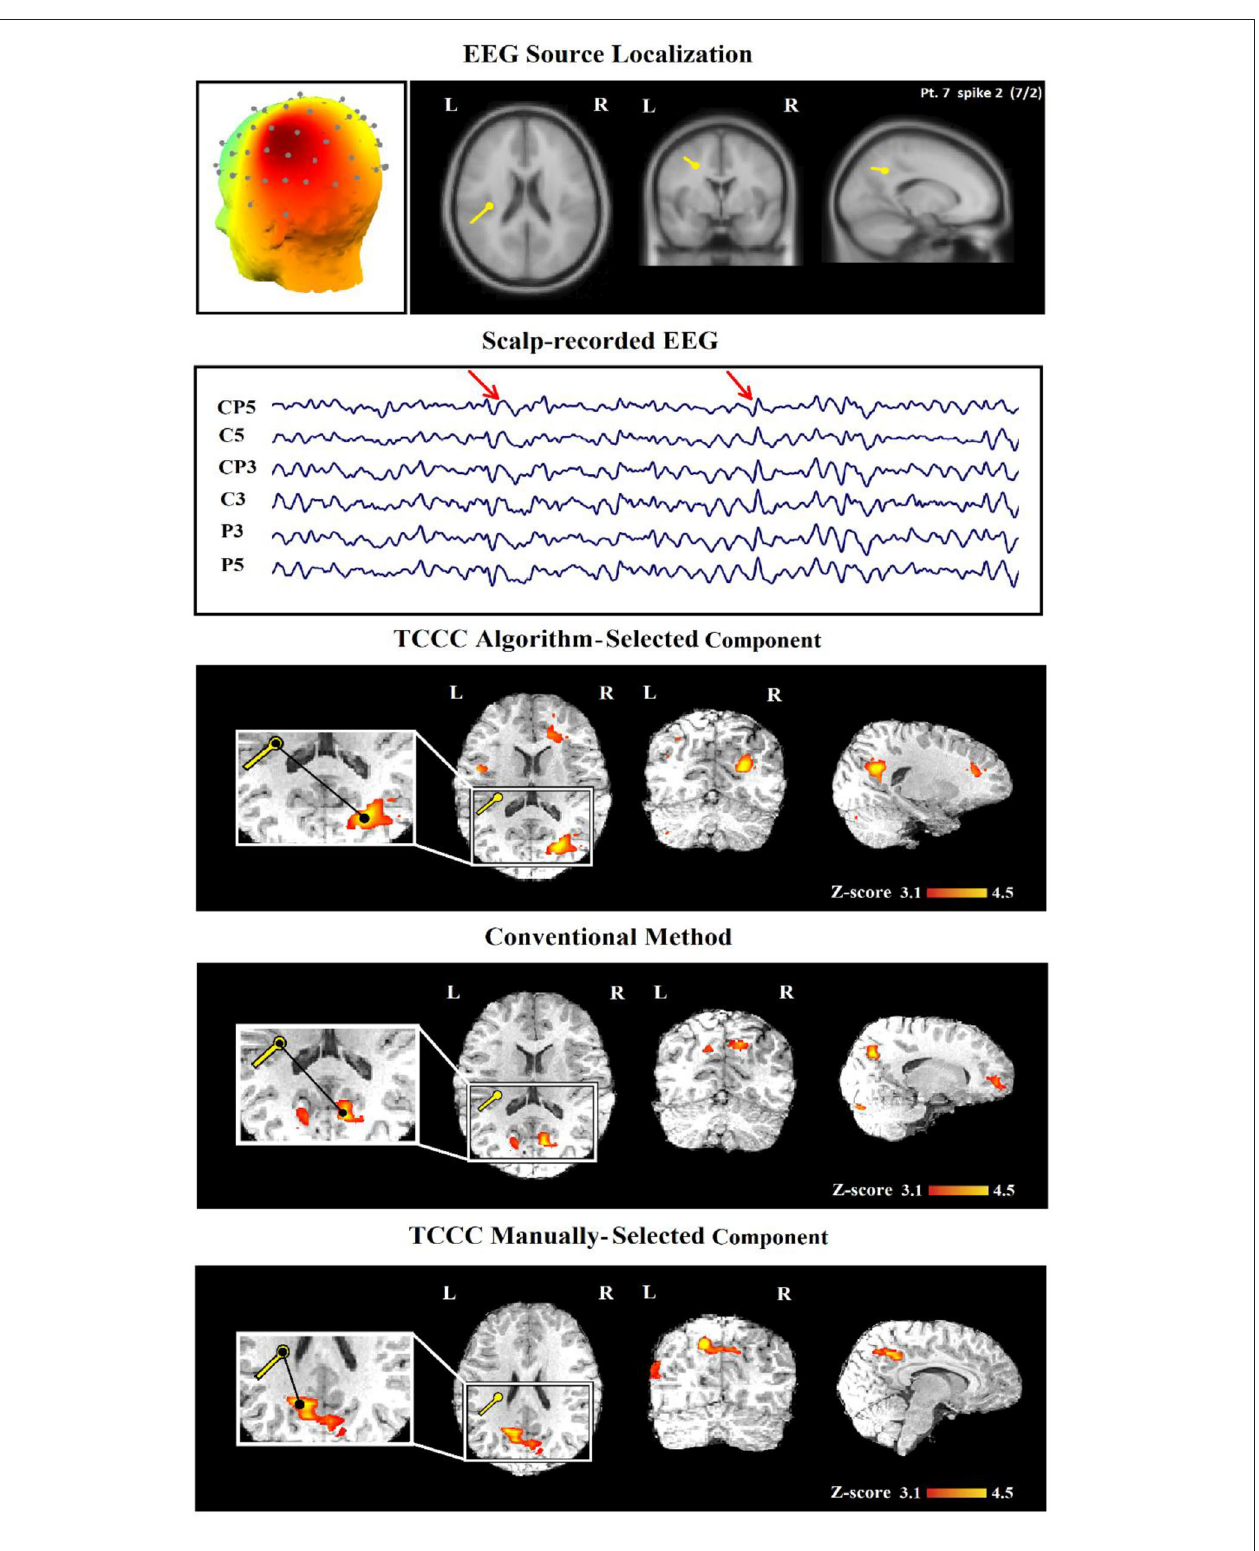
FIGURE 10 | (Patient 22—spike 2) An illustration of a sample result for conventional and TCCC methods both manually and automatically. First row, the identified component and its dipole localization in deep brain structures. Second row, scalp recorded EEG. Third row, TCCC-related BOLD response using auto-identified component (Discordant). The active area is marked with a yellow-red color. Forth row, IED-related BOLD response (conventional method). Fifth row, TCCC-related BOLD response using manually-selected component (Concordance).